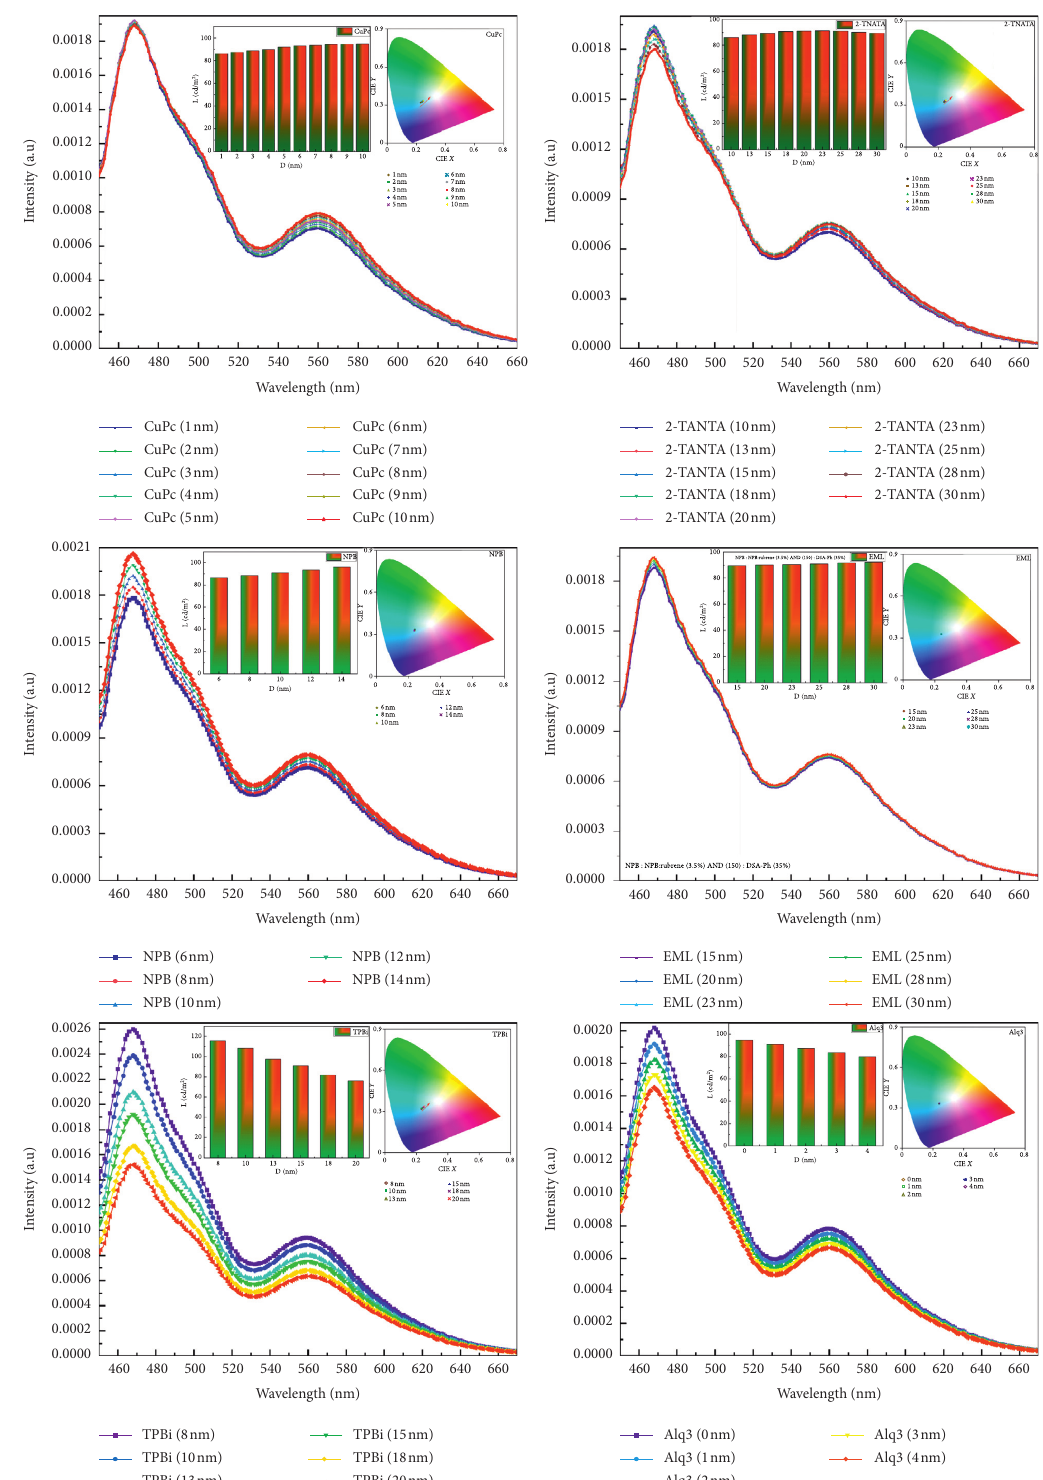
Figure 2: The influence of the thickness of organic films on the performances of OLED